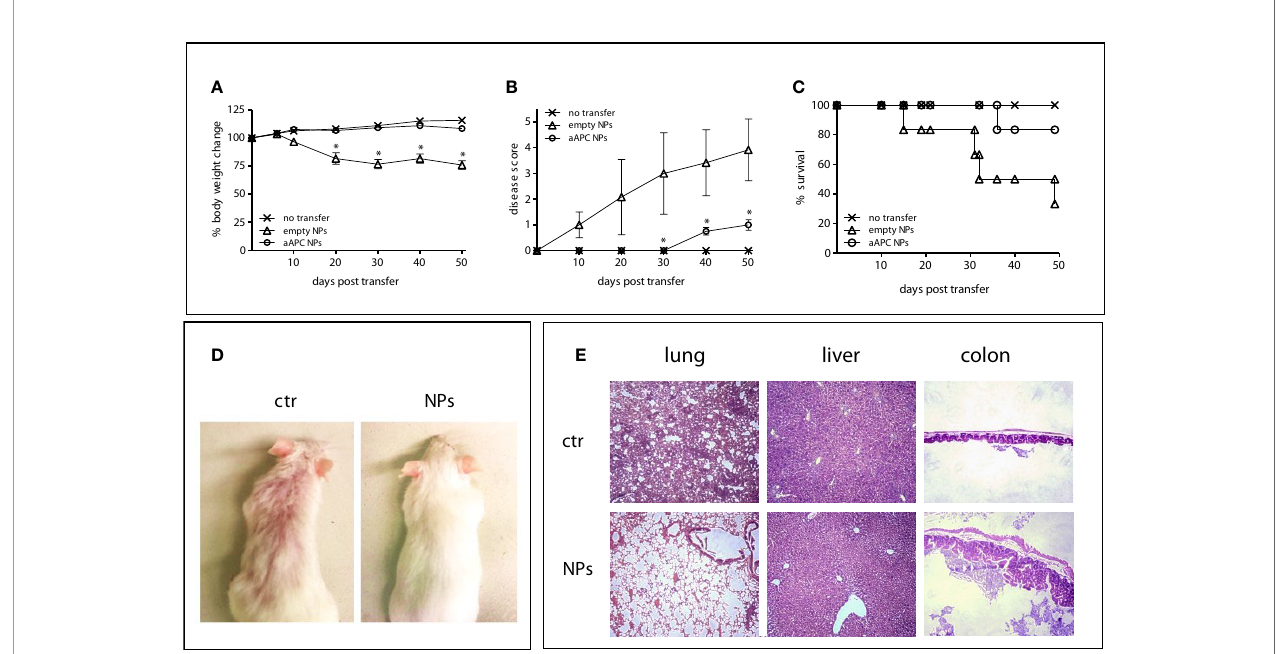
FIGURE 4 | aAPC NPs engineered to induce Tregs in vivo suppress lupus-like disease in NSG mice transferred with xenogenic human PBMCs. Six NSG mice per group were left untreated (no transfer) or injected with human PBMCs together with PBS (ctr) or aAPC NPs (see Methods ). (A – C) Body weight change (A) , clinical disease score (B) and Kaplan-Meier survival curves (C) at the time points indicated on the x axis. *P < 0.05 (aAPC NPs vs controls). (D, E) Comparisons between mice receiving aAPC NPs (NPs) or not (ctr) for skin appearance (D) and tissue histopathology of lung, liver and colon (20 x magni fi cation) (E)